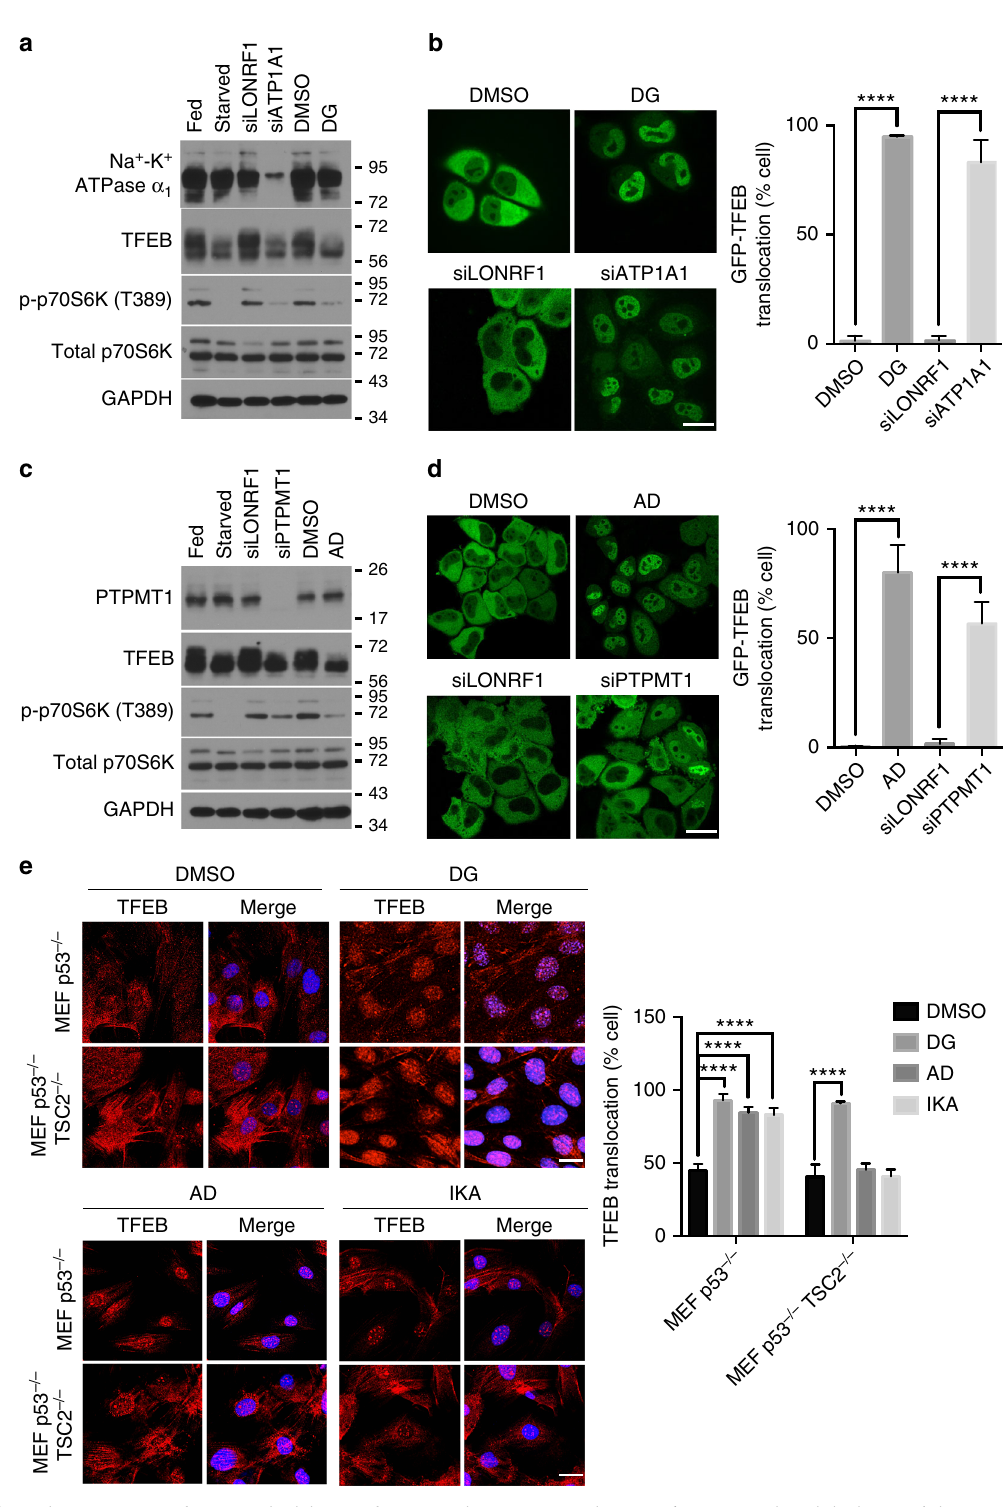
Fig. 3 Target-dependent activation of TFEB and inhibition of mTORC1 by DG, AD, and IKA. a – d siRNA-mediated depletion of the α 1 subunit of Na + -K + -ATPase ( a ) and PTPMT1 ( c ) mimics the molecular weight shift of TFEB and inhibition of mTORC1 as seen in the immunoblots of DG-treated ( a ) and AD- treated ( c ) and nutrient-deprived cells (positive controls). Representative confocal images of GFP-TFEB HeLa cells treated with DG, siATP1A1 ( b ) AD, siPTPMT1 ( d ) and their corresponding controls. siRNA against LON peptidase N-terminal domain and ring fi nger 1 (LONRF1) was used as a negative control siRNA. The graphs represent the percentage of cells with GFP-TFEB translocation under these conditions (mean ± s.d. for n = 3 independent experiments, **** p < 0.0001 by two-way ANOVA). Scale bar, 20 μ m. e To test if the compound-mediated inhibition of mTORC1 was dependent on the well-known negative regulator TSC2, we employed p53 − / − and p53 − / − , TSC2 − / − mouse embryonic fi broblasts (MEFs). Endogenous TFEB in cells treated with 370.4 nM DG, 3.3 μ M AD, or IKA or DMSO was examined by immuno fl uorescent staining. TFEB translocation percentage was quanti fi ed in the bar graph (mean ± s.d. for n = 3 independent experiments, **** p < 0.0001 by two-way ANOVA). Scale bars, 20 μ